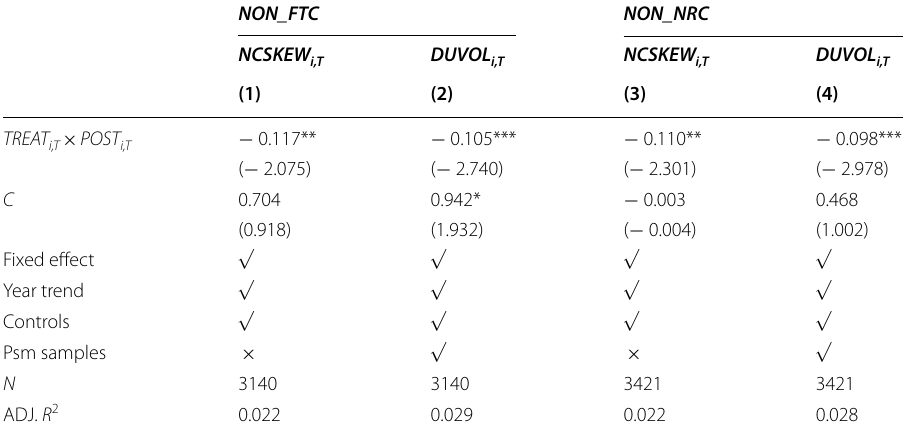
Table 7 Control of other policies’